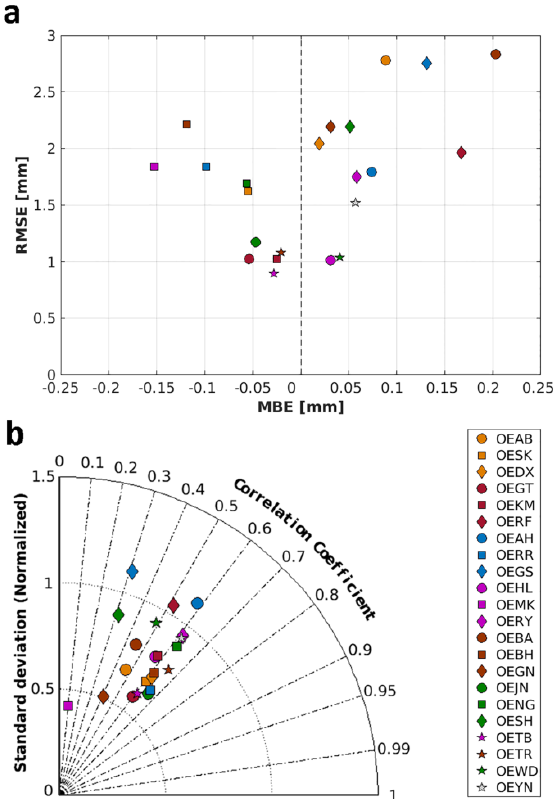
Figure 3. ( a ) MBE versus RMSE between modeled and observed precipitations and ( b ) Taylor diagram for each station.